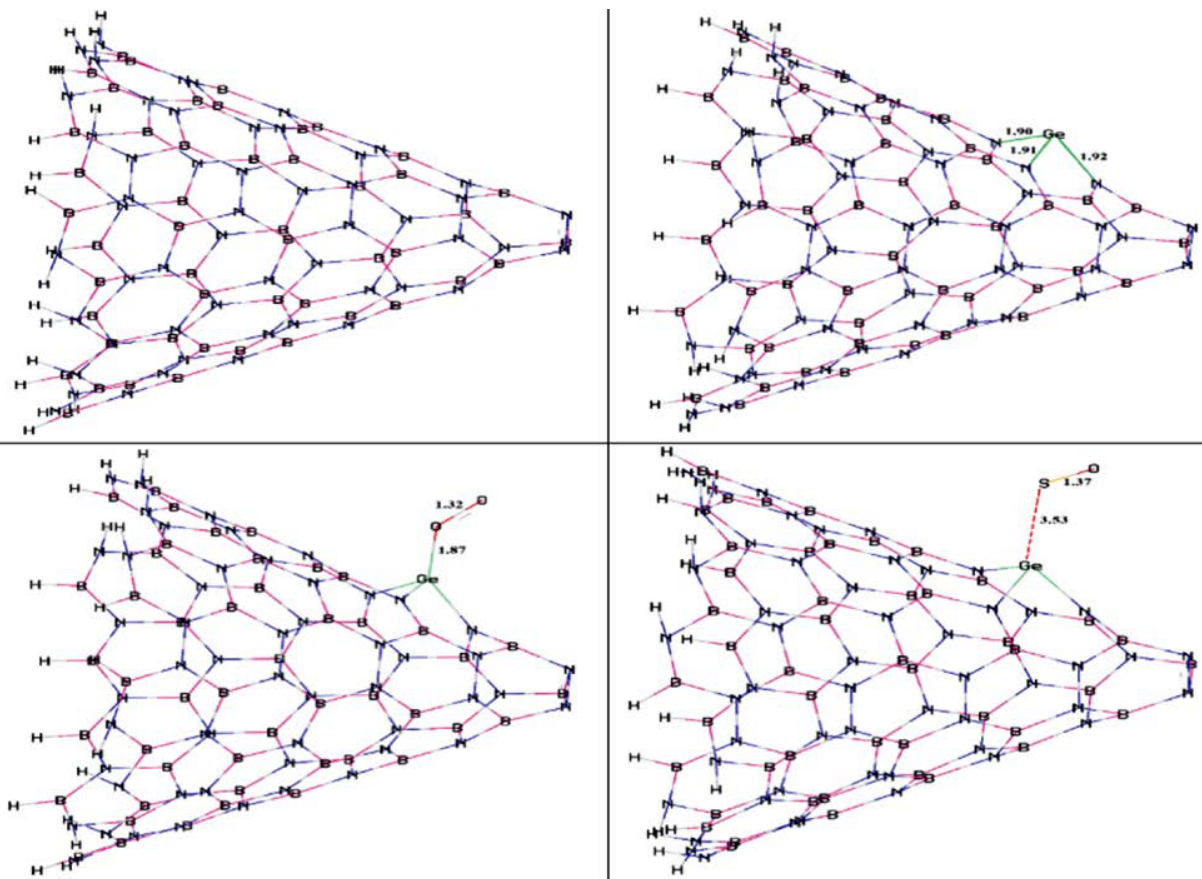
Figure 1. Structures of BNNC, Ge-BNNC, Ge-BNNC-O 2 and Ge-BNNC-SO (bond distances